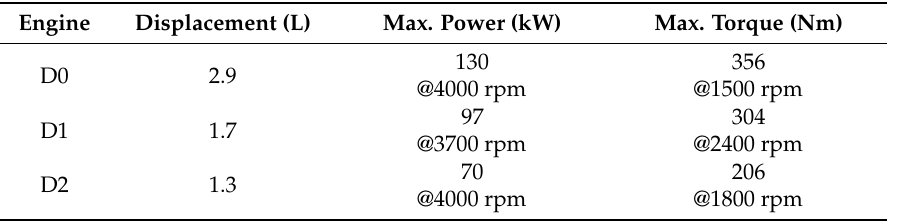
Table 2. Main specifications of the three diesel